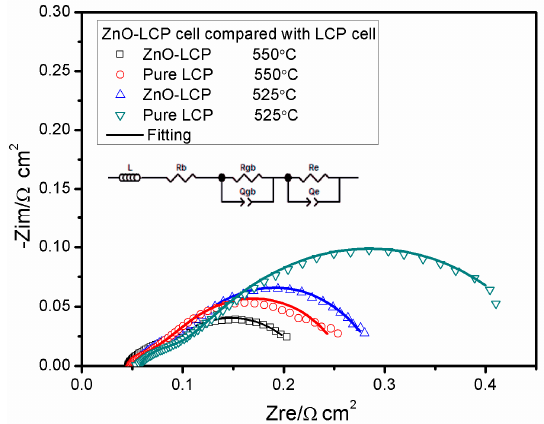
Figure 7. Impedance spectra for ZnO-LCP fuel cell and LCP fuel cell measured in H 2 /air at two different temperatures and the corresponding fitting lines. The inset is equivalent circuit adopted for fitting the EIS data.